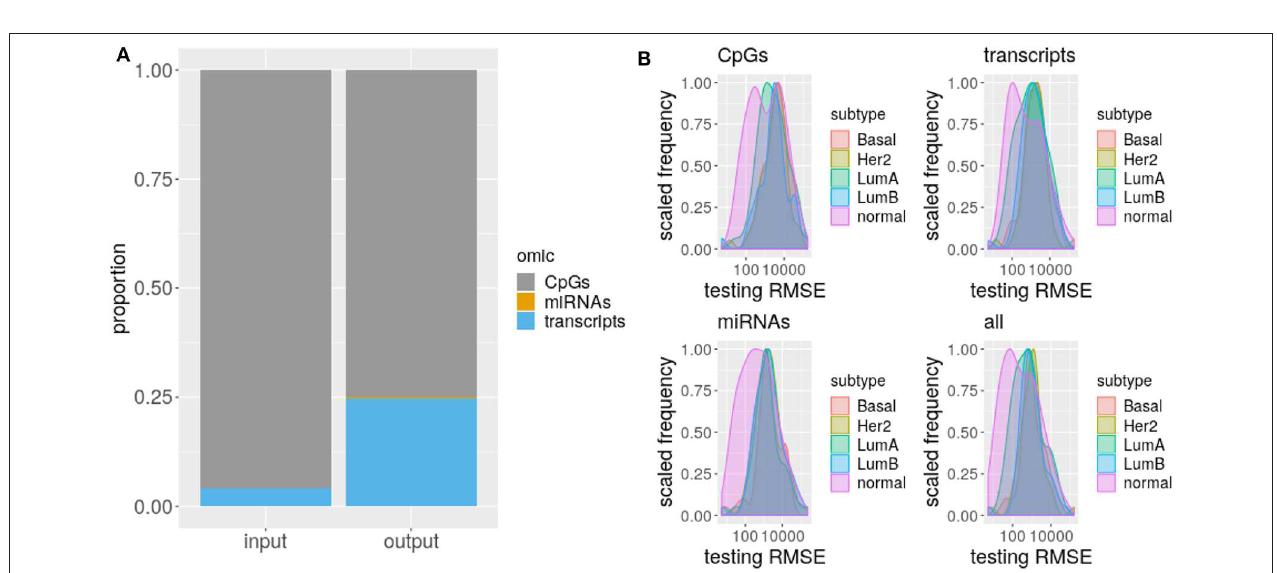
FIGURE 3 | Omics differ on selection and RMSE. (A) The proportion of each omic is shown for input and selected sets. The different omics are represented by a different color. (B) Distribution of testing RMSE per subtypes are displayed for single and multi-omics.